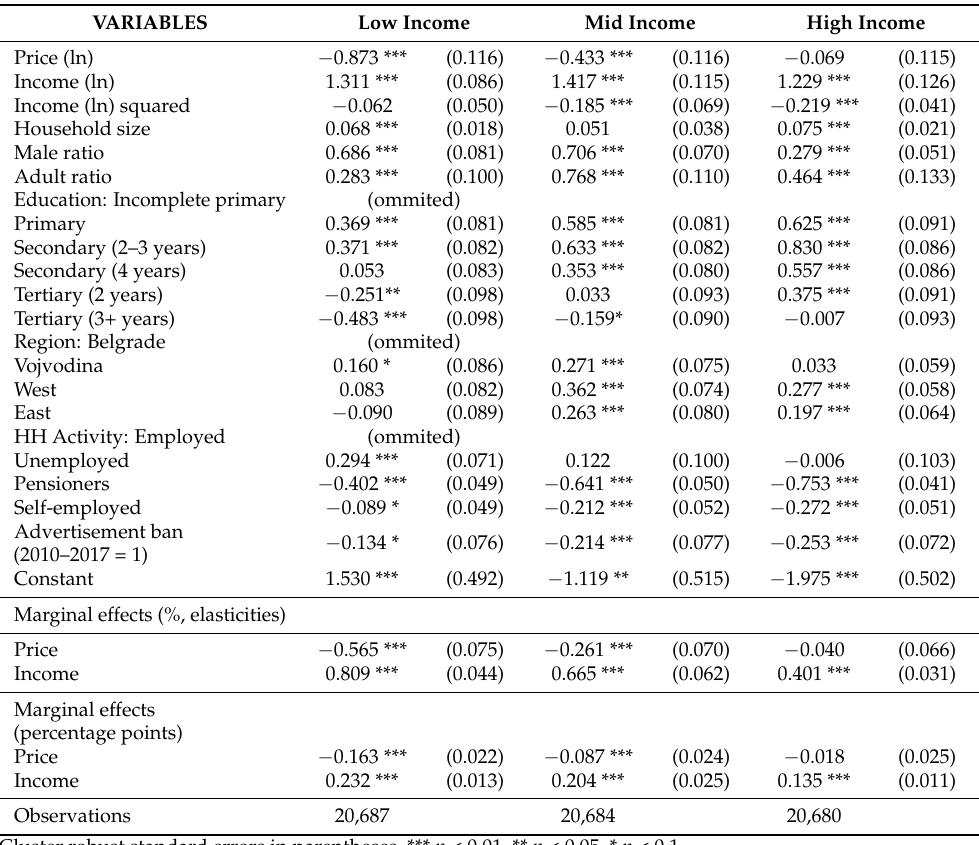
Table A4. Estimation of the prevalence elasticity by income groups.